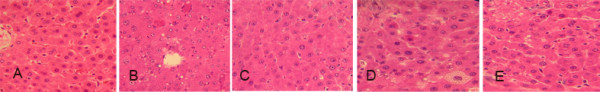
Histopathological changes in rat livers. Livers of rats in model, 1%, 2%, and 4% betaine groups: widespread malignant cells were observed, the model group showed most severe malignancy. Original magnification: 10 × 40. A: Control; B: Model; C: 1% betaine; D: 2% betaine; E: 4% betaine.